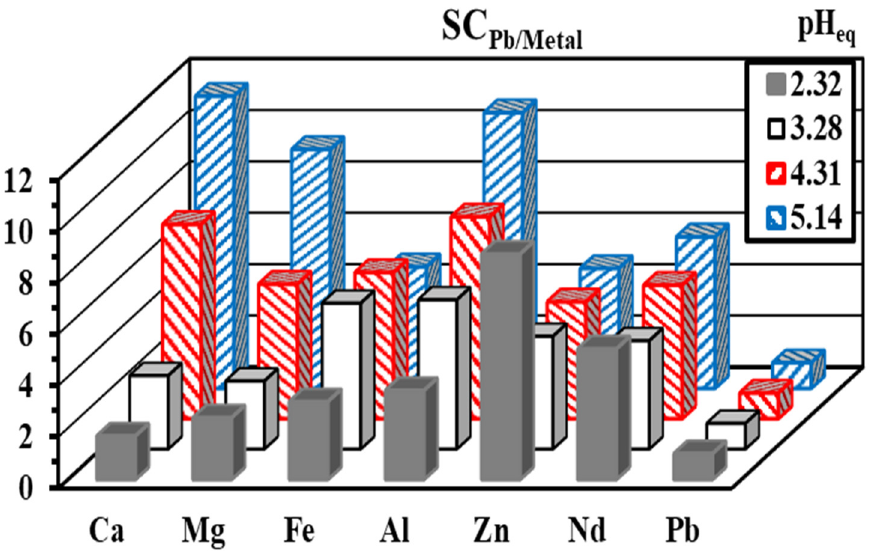
Figure 10. Selectivity coefficient of MCa-ATA for Pb over the other associated elements in polymetallic solution .